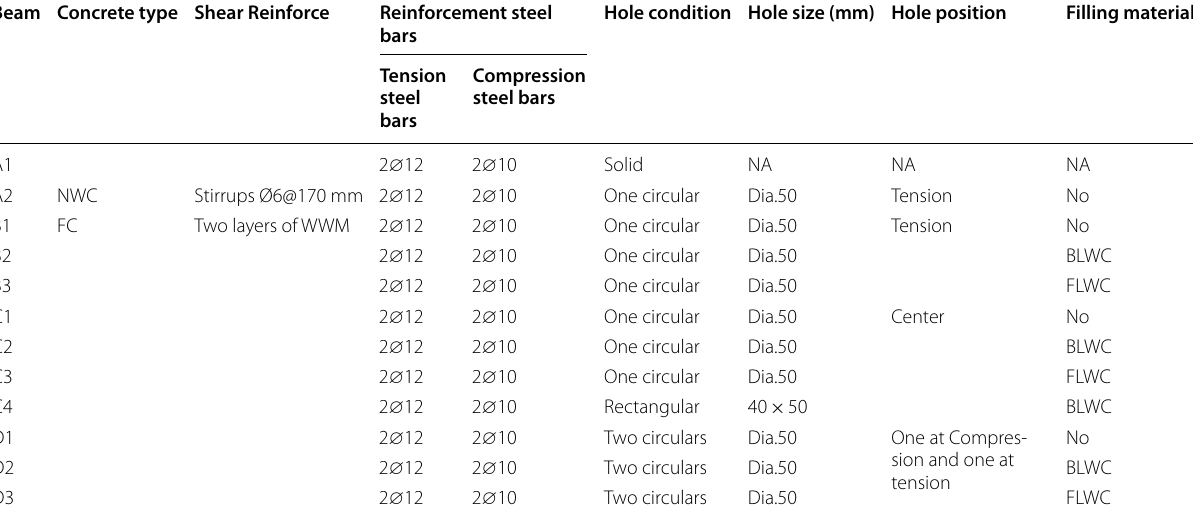
Table 3 Details of the test specimens Beam Concrete type Shear Reinforce